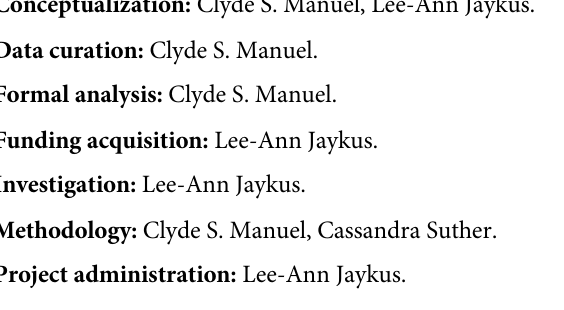
S1 Fig. Comparison of real-time RT-PCR using different starting volumes of RNA tem- plate. Each dilution was repeated two times for template volume tested. Standard error bars are shown for each curve. A t-test was applied to all dilutions. No significant difference was observed ( p >